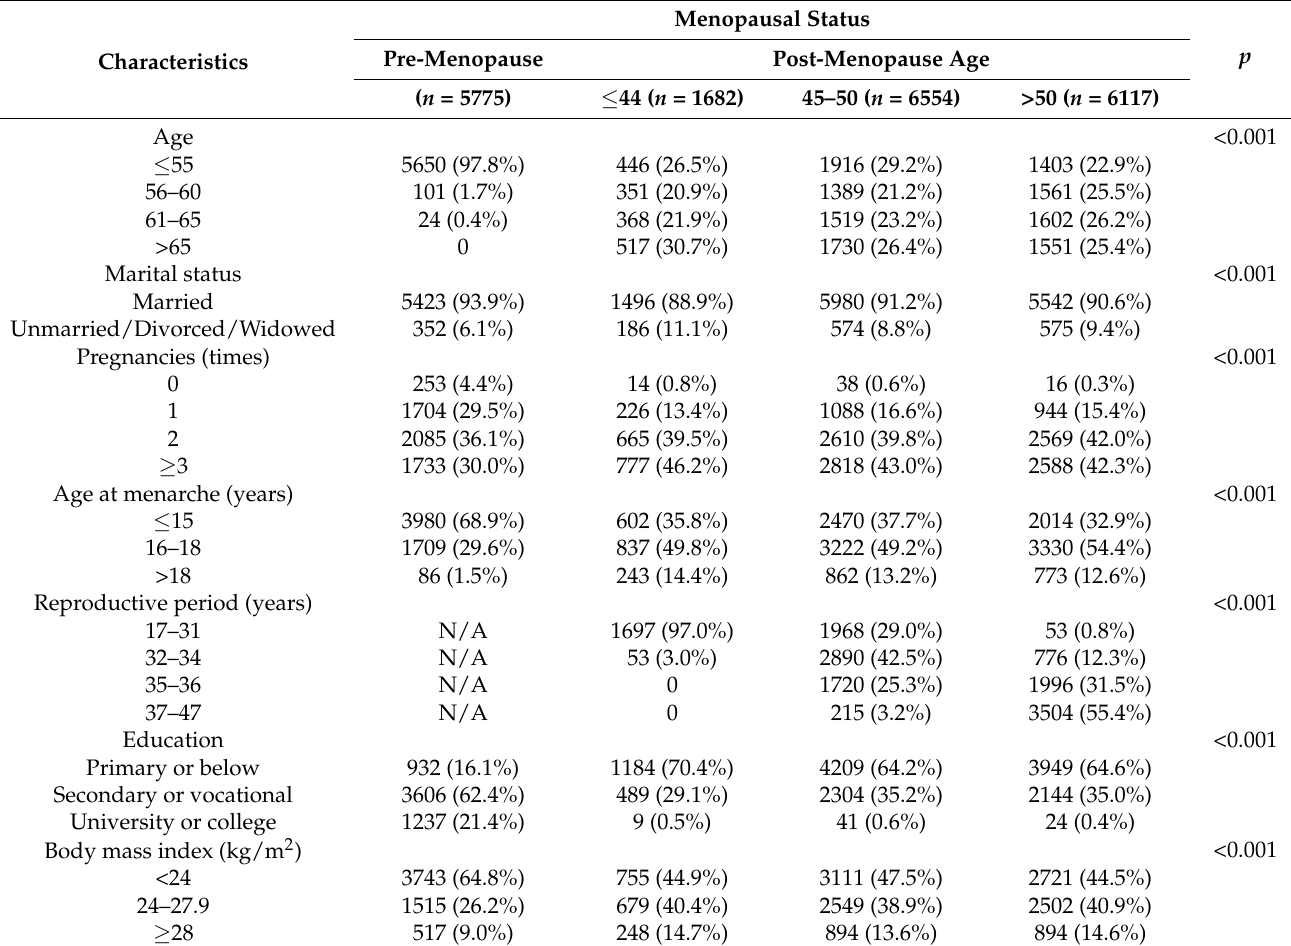
Table 1. Characteristics of the women with menopausal status ( n =